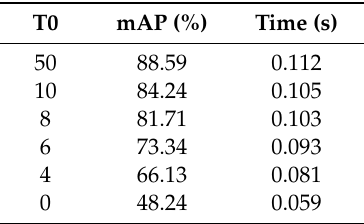
Table 2. Results of di ff erent thresholds T0 [31] representing the maximum number of regions detected sequentially on one video